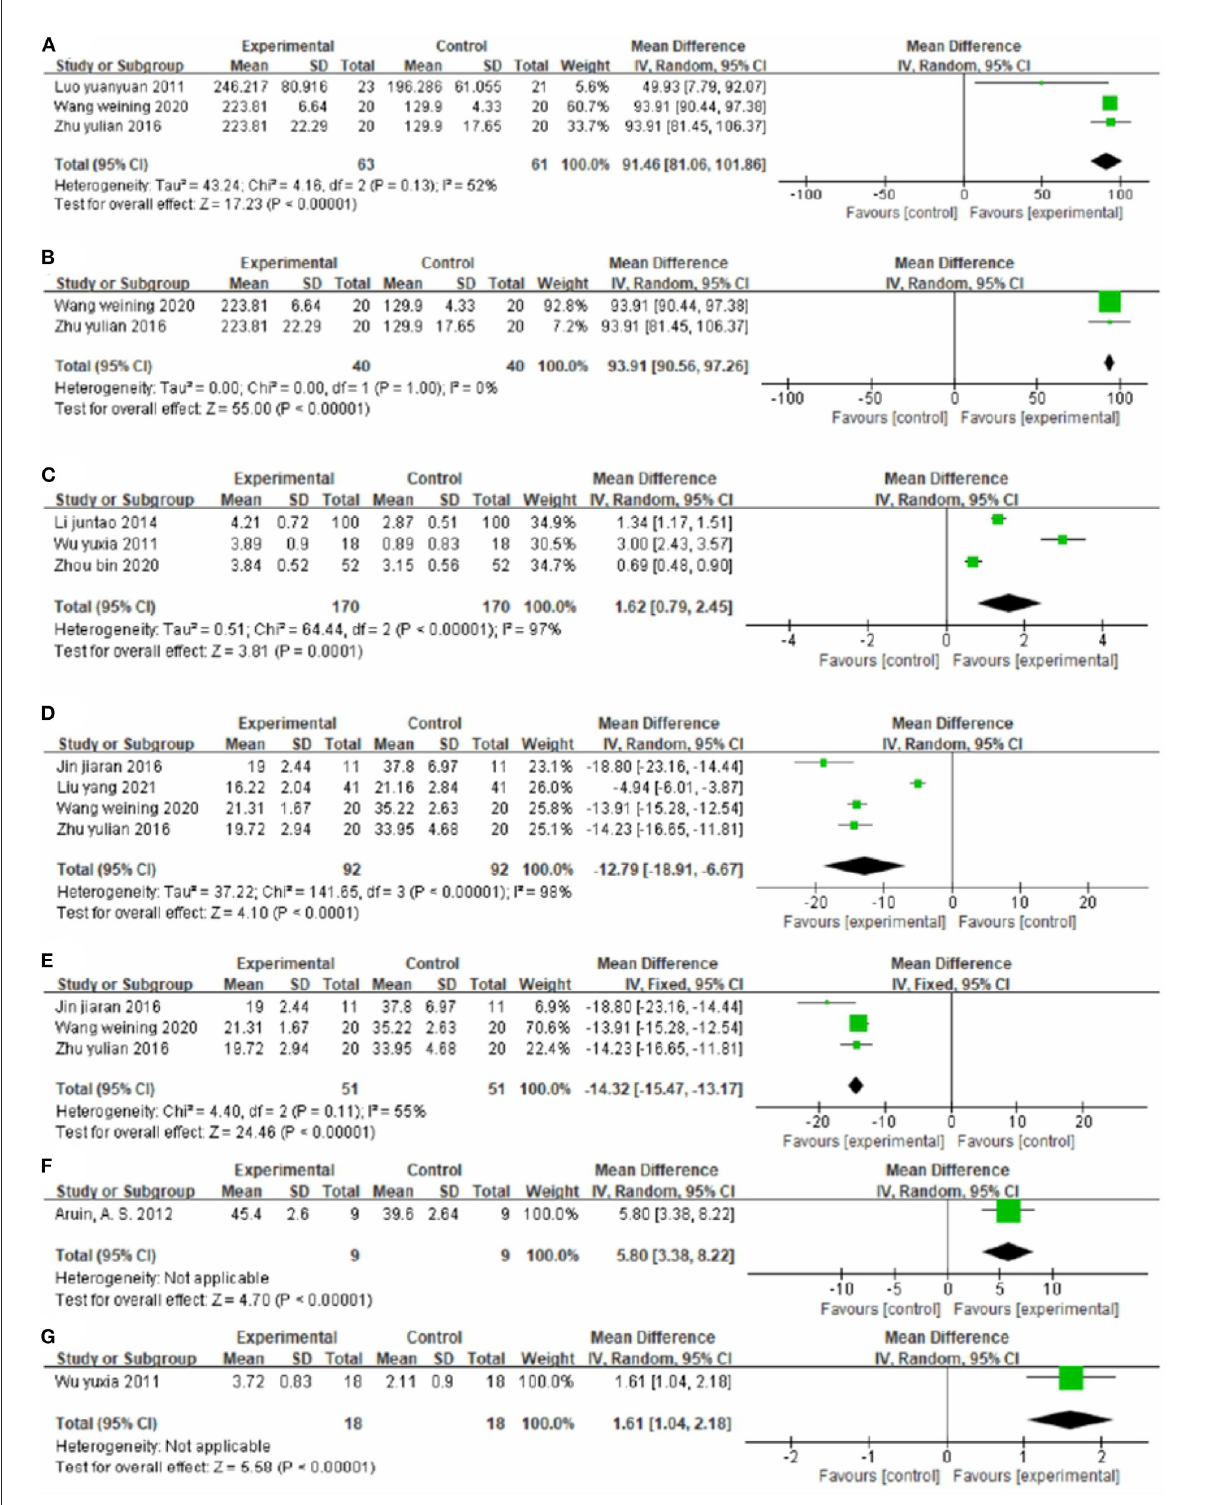
FIGURE11 Forest plot. CIMT plus conventional physiotherapy vs. conventional physiotherapy alone on the 6-min walk test (A,B) , functional ambulation category scale (C) , timed up and go test (D,E) , weight-bearing (F) and Brunnstrom stage of lower limb function (G)